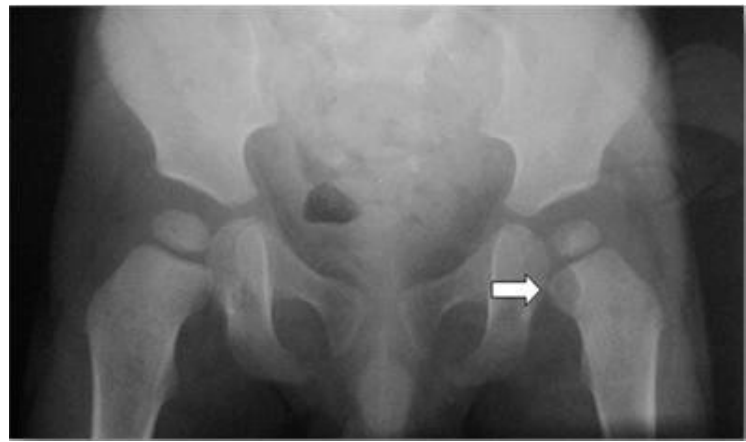
Figure 1. X-rays of the pelvis. Osteolytic lesion of the proximal metaphysis of the left femur (arrow).